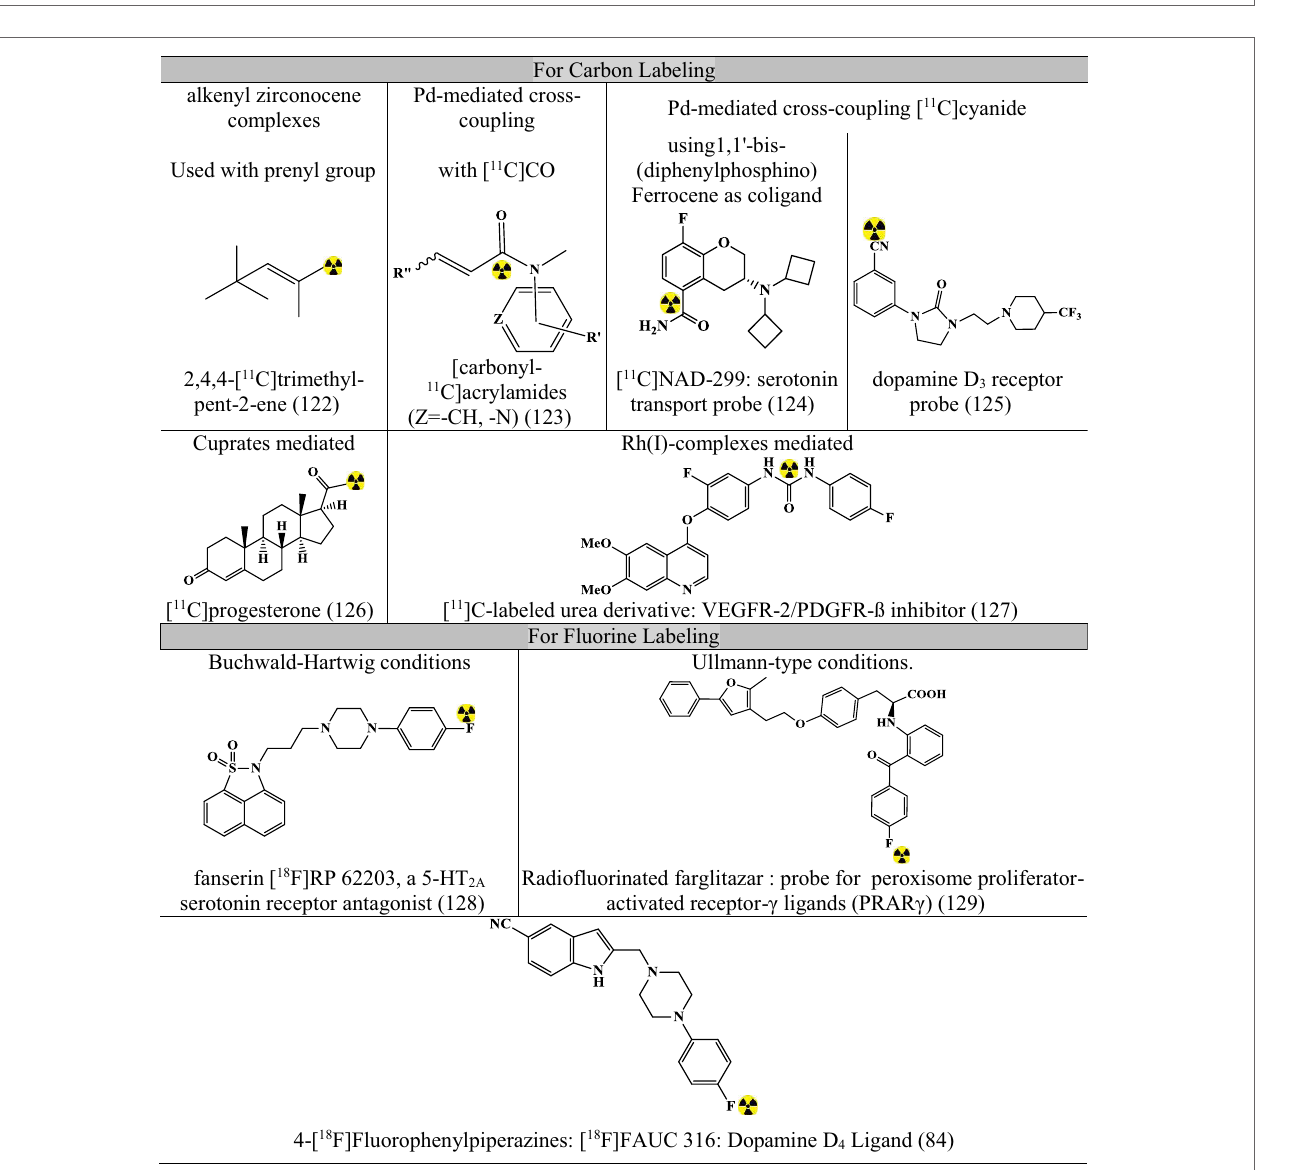
FiGURe 10 | Radiopharmaceutical developed using Heck reaction. Structures referenced in (82, 121).